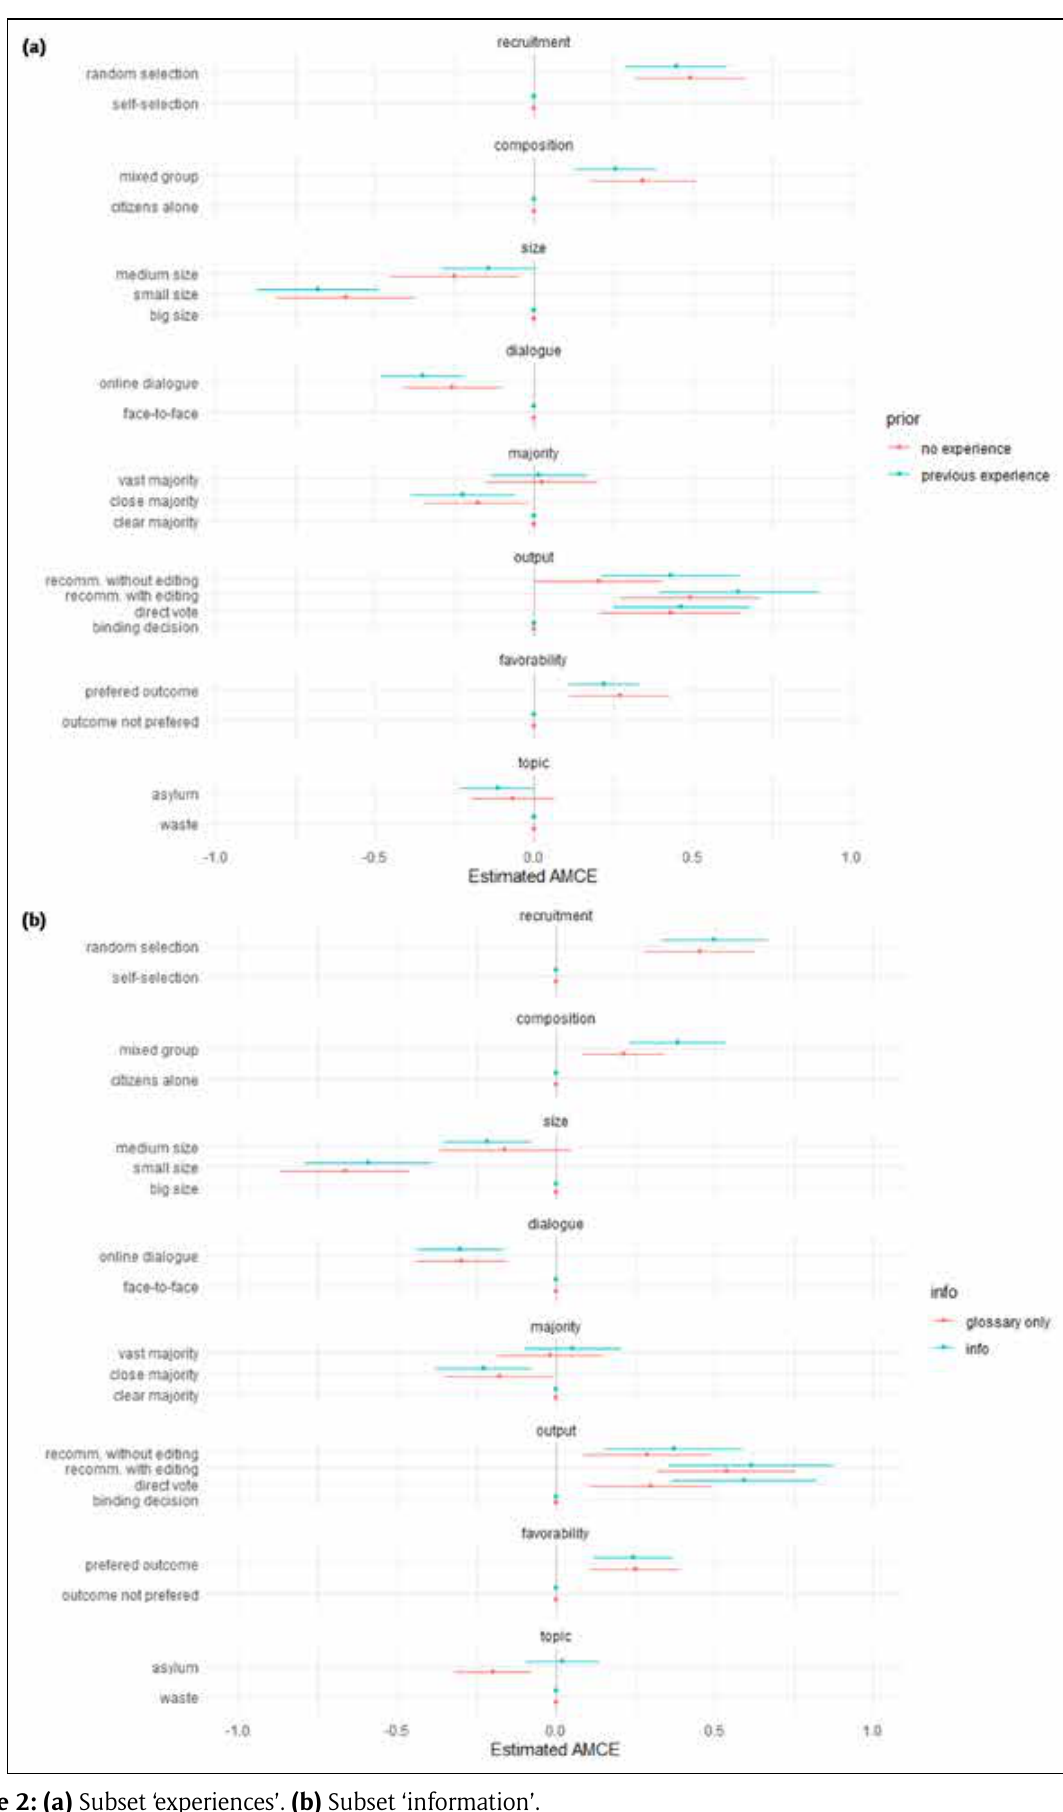
Figure 2: (a) Subset ‘experiences’. (b) Subset